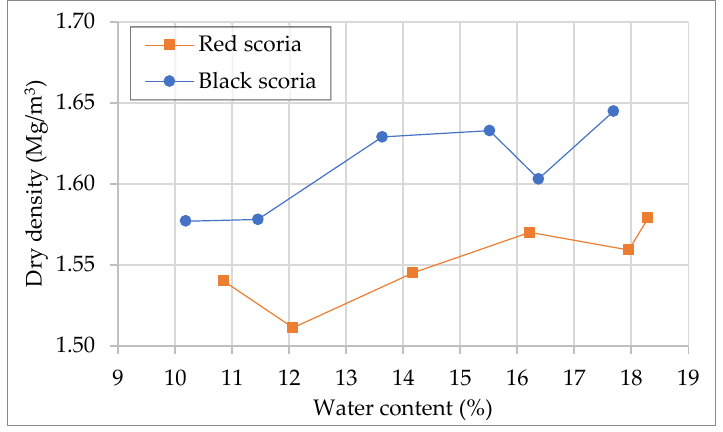
Figure 4. Dry density/water content relationship curves of the red and black scoria.